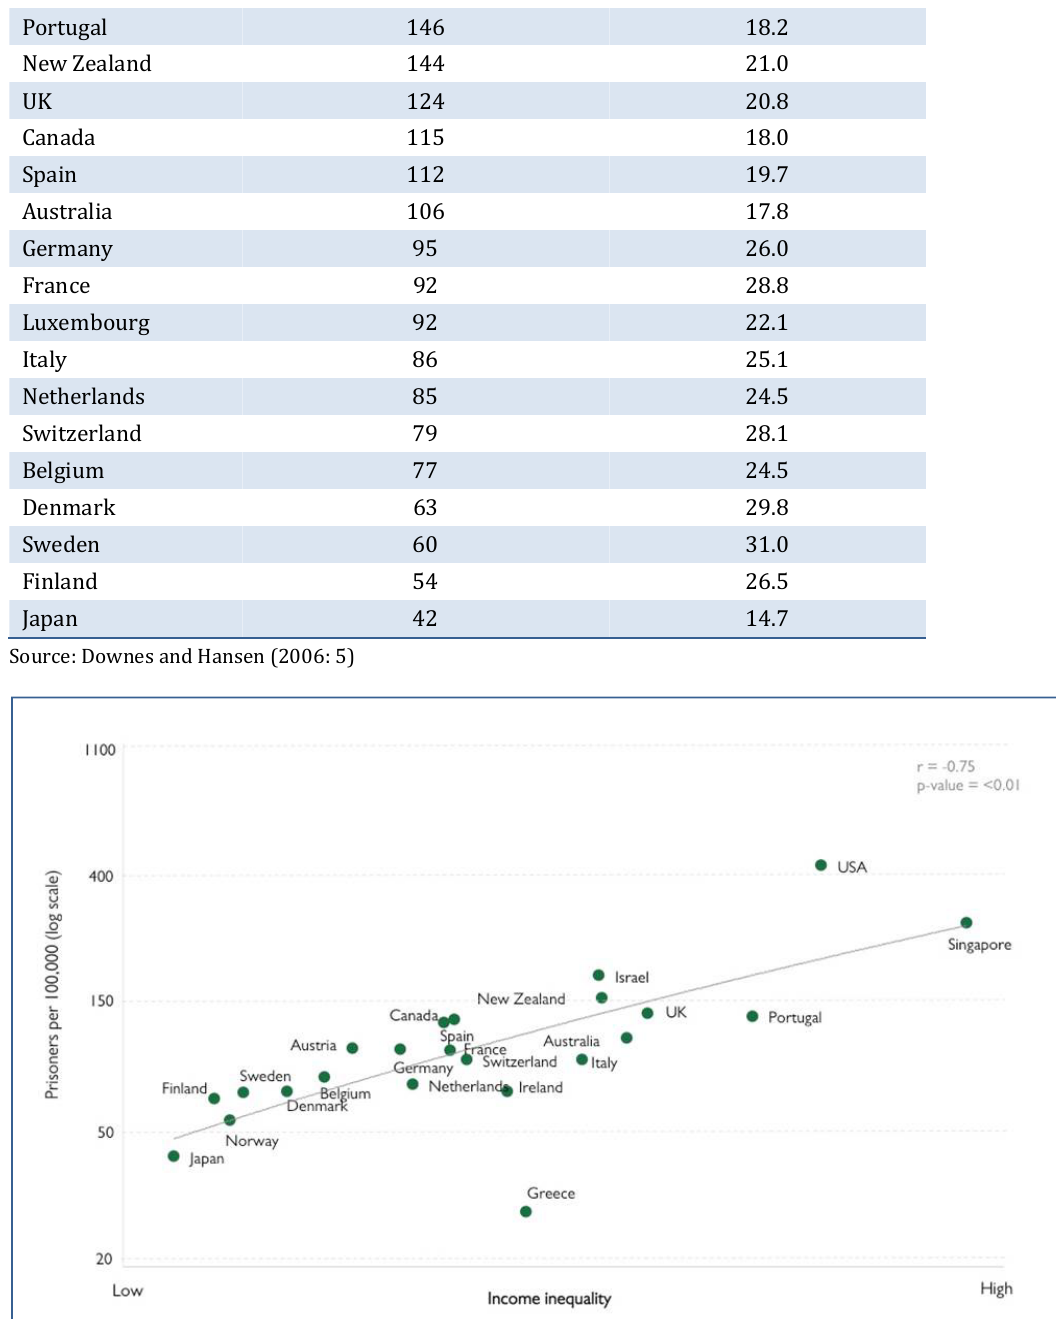
Table 7: The relationship between welfare expenditure and prison rates, 1998 Imprisonment rates per Country 100,000 population(15+) % of GDP on welfare 666 14.6